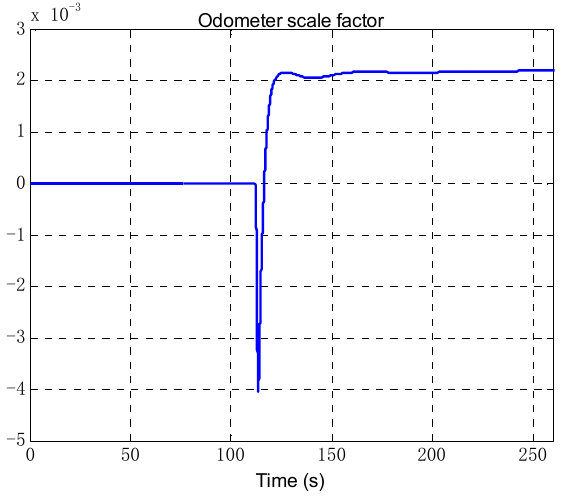
Figure 13. The estimation of odometer scale factor.